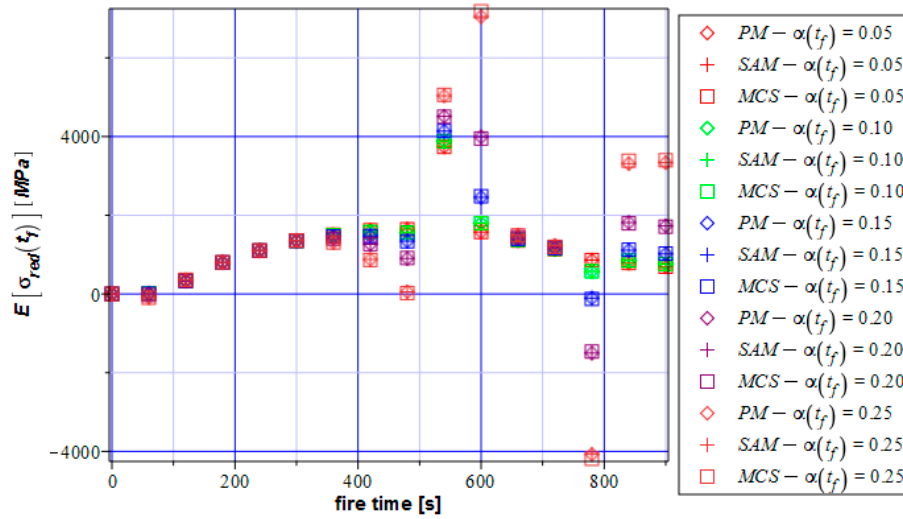
Figure 15. Expectations of reduced stress.